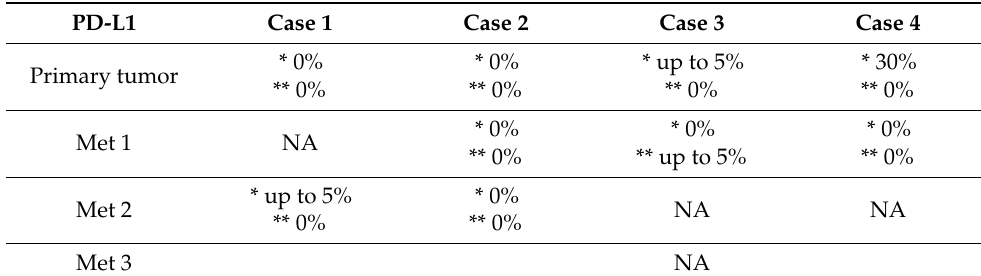
Table 3. PD-L1 reactivity in the primary tumor and metastases.